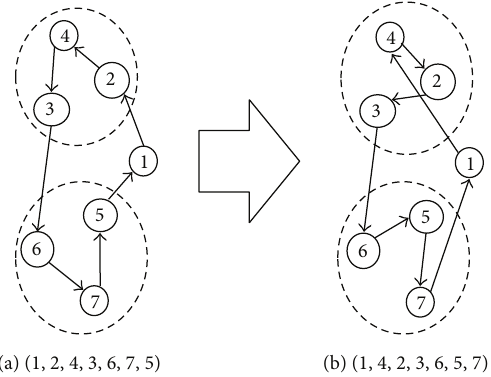
Figure 3: Example of reciprocal exchange mutation